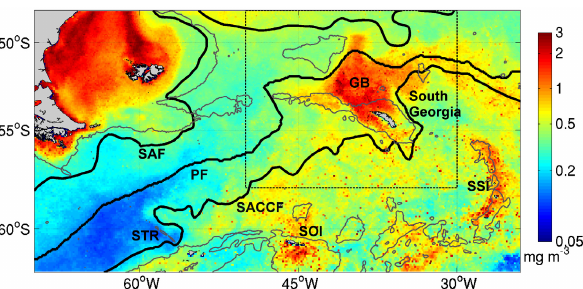
Fig. 1. Chlorophyll a climatology derived from SeaWiFS austral summer (December–February, from 1997–2010) in the southwest- ern sector of the Atlantic Southern Ocean. Bold lines indicate the Subantarctic Front (SAF, Orsi et al., 1995), the Polar Front (PF, Moore et al., 1999) and the Southern ACC Front (SACCF, Thorpe et al., 2002). Bathymetric contours for the 2000m are indicated with thin lines. The position of the Shackleton Transverse Ridge (STR), that of the South Orkney Islands (SOI), the Georgia Basin (GB) and the South Sandwich Islands (SSI) are also indicated.